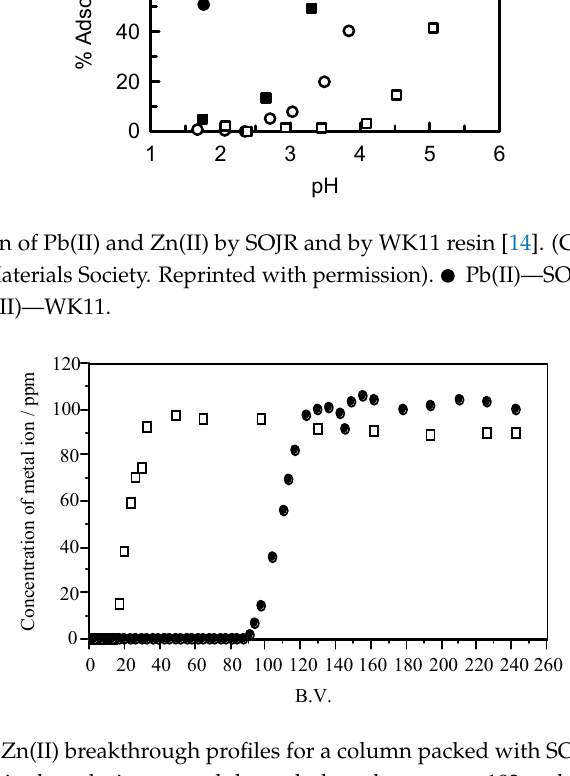
Figure 16. Pb(II) and Zn(II) breakthrough profiles for a column packed with SOJR gel. The Pb(II) and Zn(II) concentrations in the solution passed through the column were 102 and 96 mg/L, respectively, and the pH was 2.6. Flow rate = 5.5 mL/h, dry weight of SOJR gel = 100 mg [14]. (Copyright 2003 by The Minerals, Metals & Materials Society. Reprinted with permission).